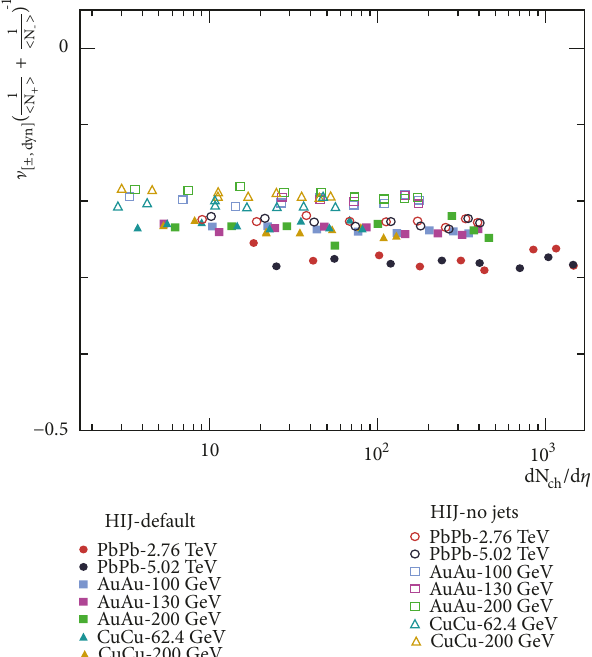
Figure 9: The same plot as in Figure 8 but after applying corrections to ] [+−,𝑑𝑦𝑛] values. Figure 10: 1/(1/⟨𝑁